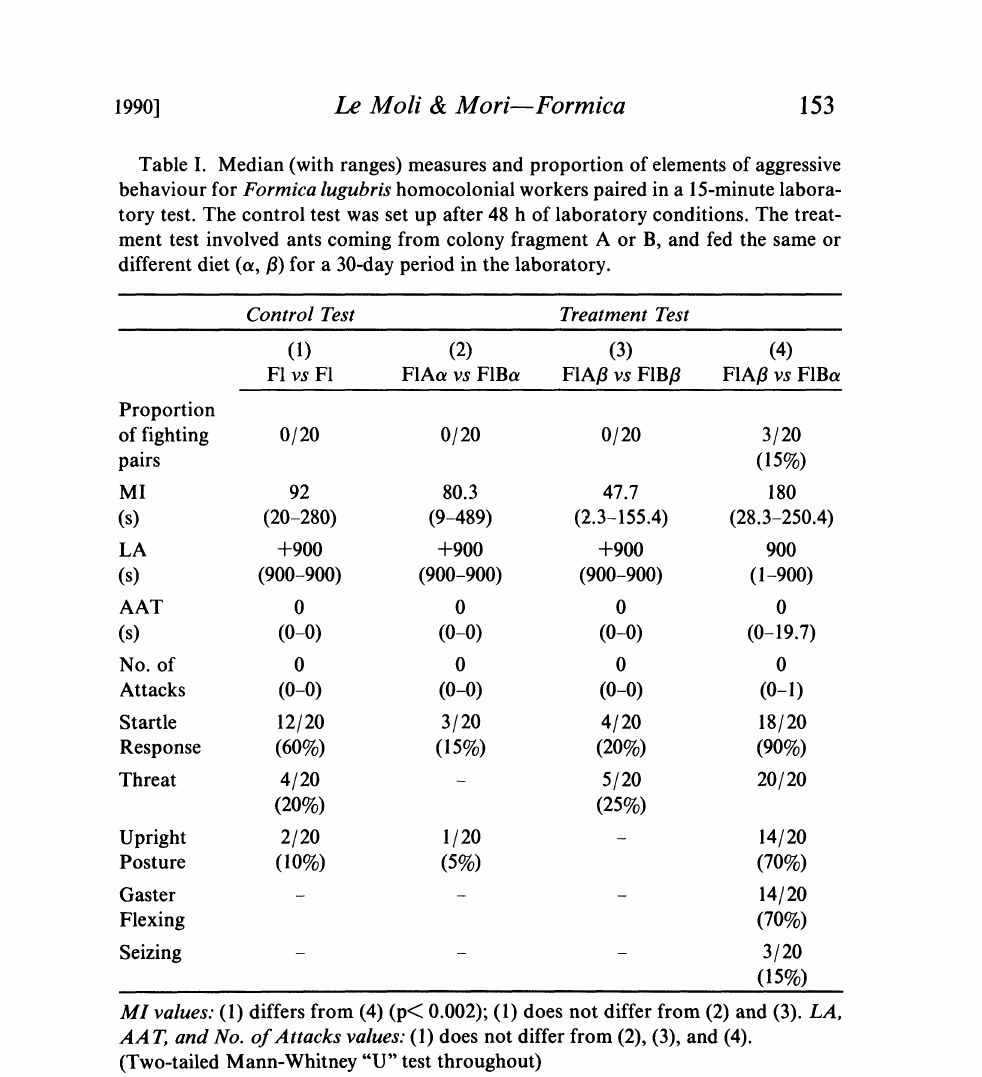
Table I. Median (with ranges) measures and proportion of elements of aggressive behaviour for Formica lugubris homocolonial workers paired in a 15-minute labora- tory test. The control test was set up after 48 h of laboratory conditions. The treat- ment test involved ants coming from colony fragment A or B, and fed the same or different diet (t,/3) for a 30-day period in the